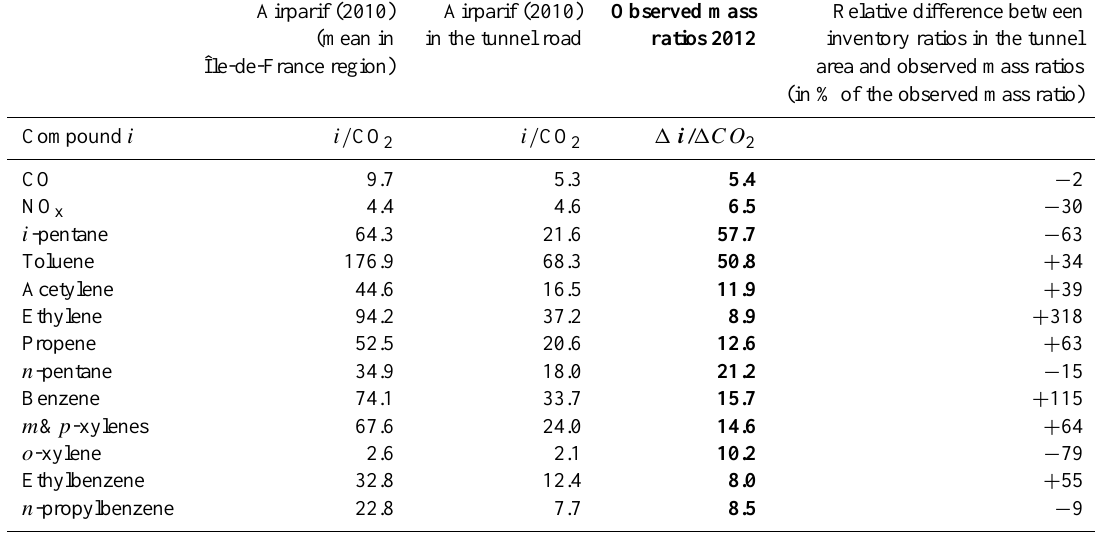
Table 3. Comparison between mass observed ratios to CO 2 and mass emission ratios provided by the 2010 Airparif inventory, only for the traffic source. The first column shows ratios from the Airparif inventory for the whole Île-de-France region, the second one shows the specific Airparif ratios for the tunnel road. Observed ratios are in bold. The last column reports the relative differences between the specific Airparif ratios for the tunnel road and observed mass ratios. Emission ratios for CO and NO x are reported in tkt − 1 , all others are reported in kgkt − 1 .